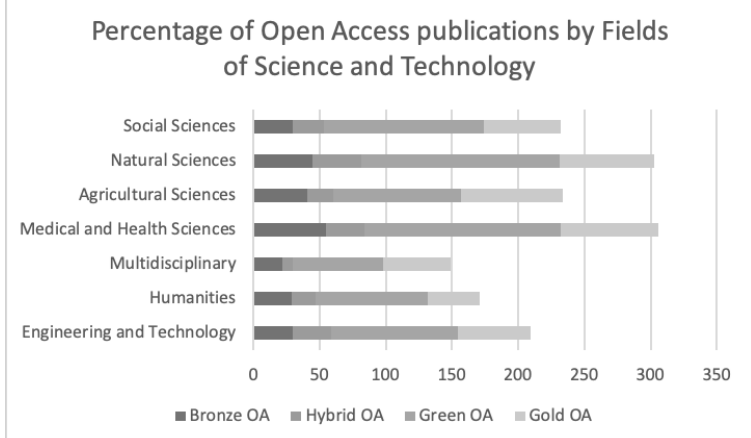
Fig. 7 Percentage of Open Access publications per type and domain (1979-2020). Source: Open Science Monitoring, Reference date 2009-2018, our